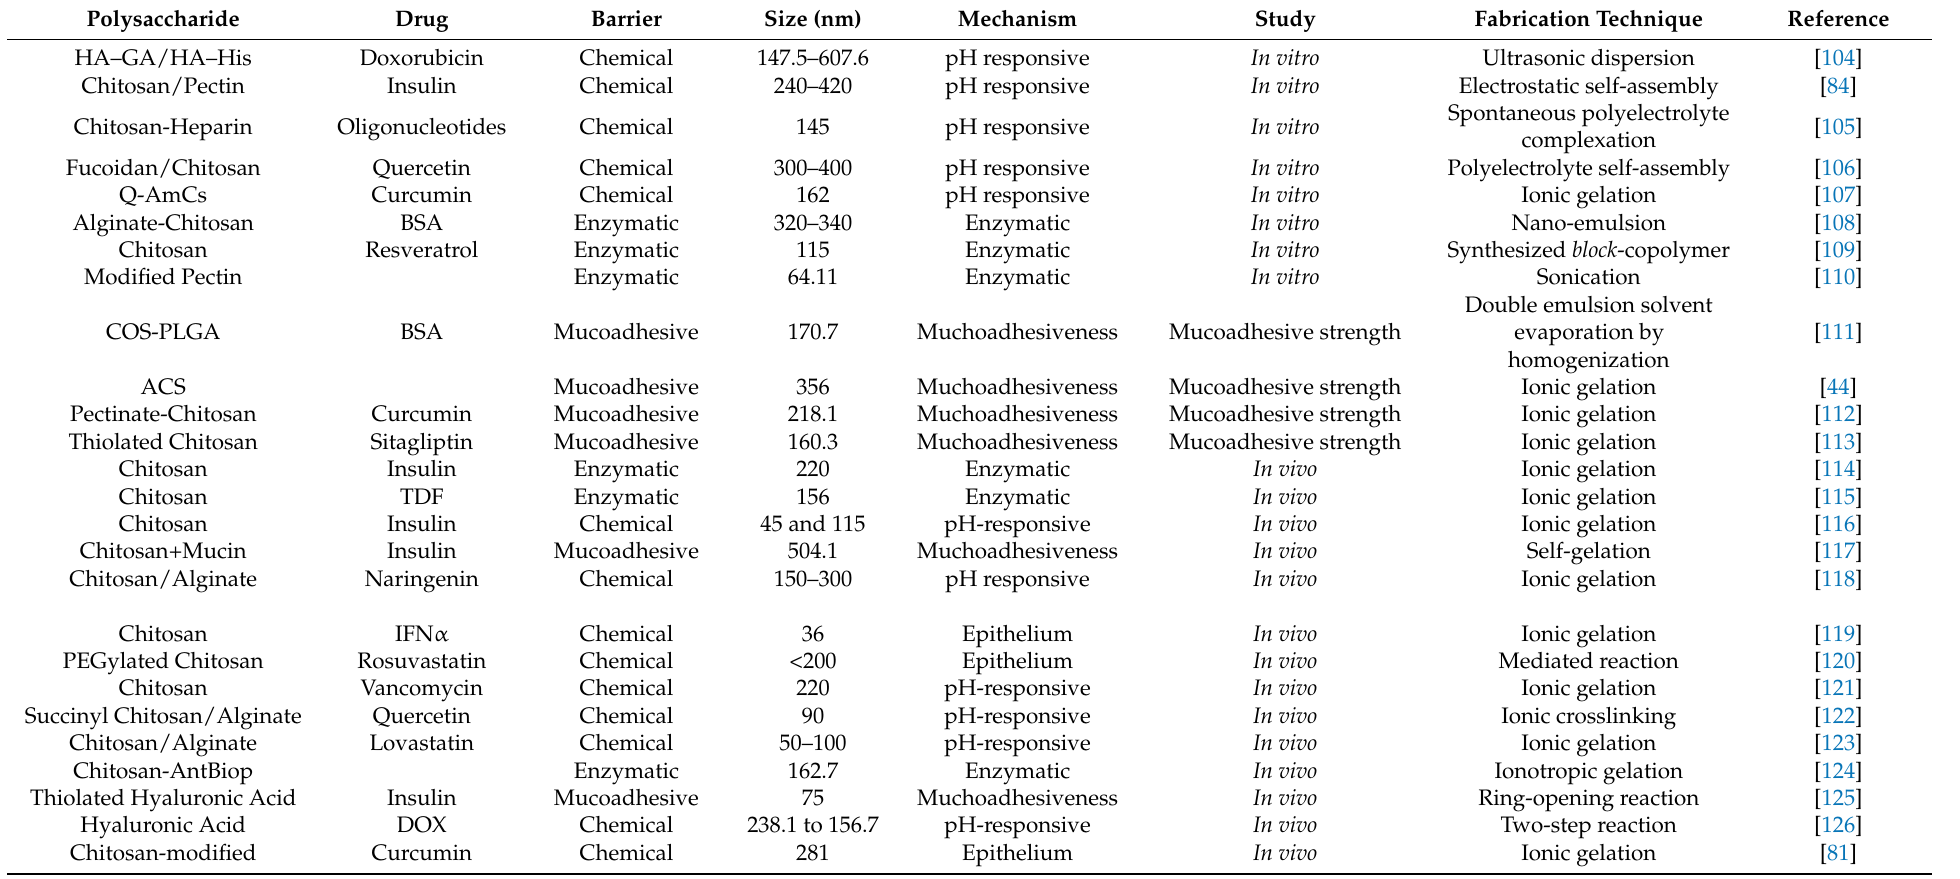
Table 3. Polysaccharide-based nanoparticle colon-specific drug